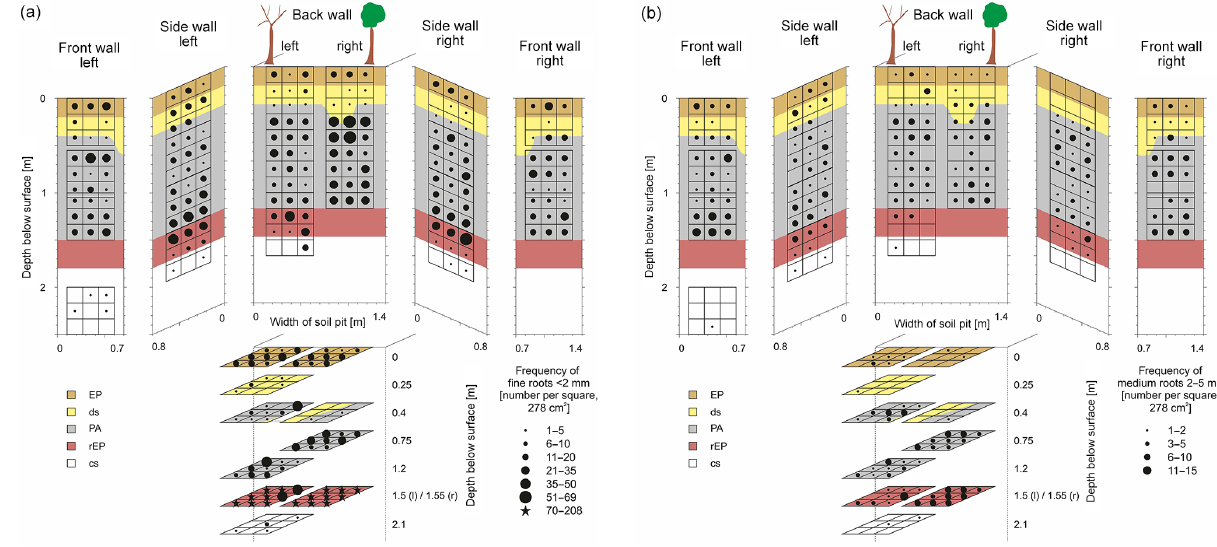
Figure 8. Frequencies of (a) fine and (b) medium roots determined at different places within the soil pit.